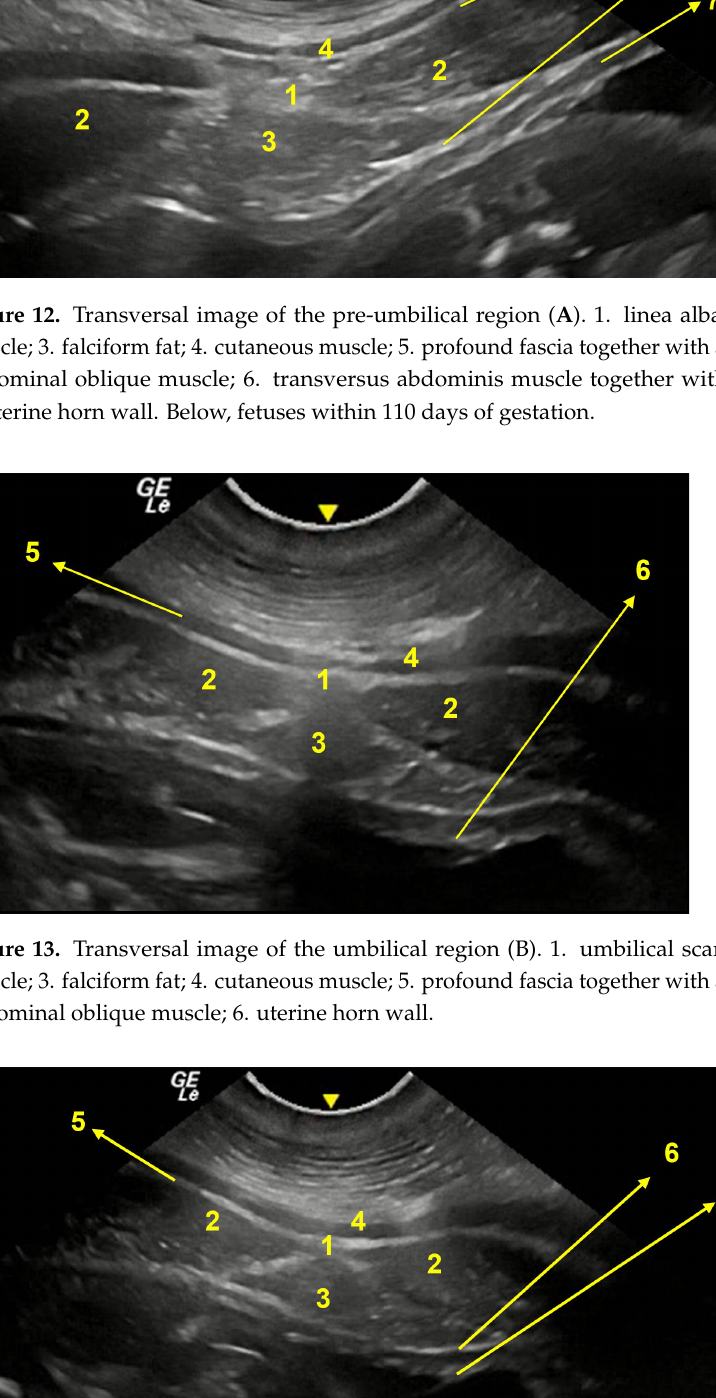
Figure 14 . Transversal image of the post-umbilical region (C). 1. linea alba; 2. rectus abdominis muscle; 3. falciform fat; 4. cutaneous muscle; 5. profound fascia together with aponeurosis of abdominal external oblique muscle; 6. transversus abdominis muscle aponeurosis together with parietal peritoneum; 7. uterine horn wall.